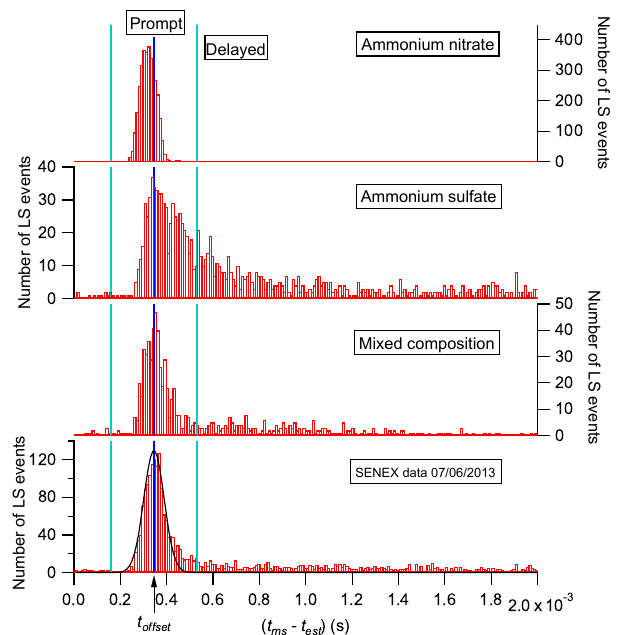
Figure 1. Histograms (red) of the time for the maximum mass spec- tral signal ( t ms ) minus the estimated time ( t est ) for particles to ar- rive at the vaporizer based on the time of the maximum intensity of the scattered light signal for particles composed of pure ammo- nium nitrate, pure ammonium sulfate, mixed composition (organic dicarboxylic and carbonyl acids, ammonium organic acid salts, am- monium sulfate, and ammonium nitrate), and the SENEX flight data on 6 July 2013. The Gaussian fit to the SENEX histogram is shown in black. The offset time ( t offset ) from the fit for the SENEX data (the dark blue vertical line) is similar to the offset times for the lab- oratory particles. The distances between dark blue line and cyan lines are three times the width of the SENEX Gaussian fit. Prompt particles are defined as those with times between the cyan lines and delayed particles are detected at later times on the right-hand side of the